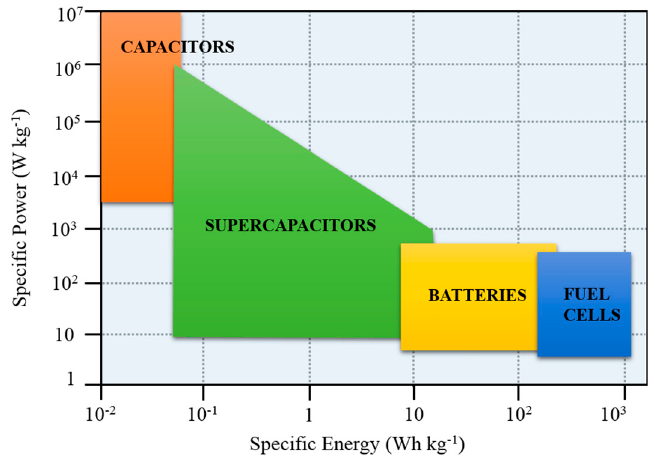
Figure 1. Ragone plots for different types of energy-storage devices [7] .